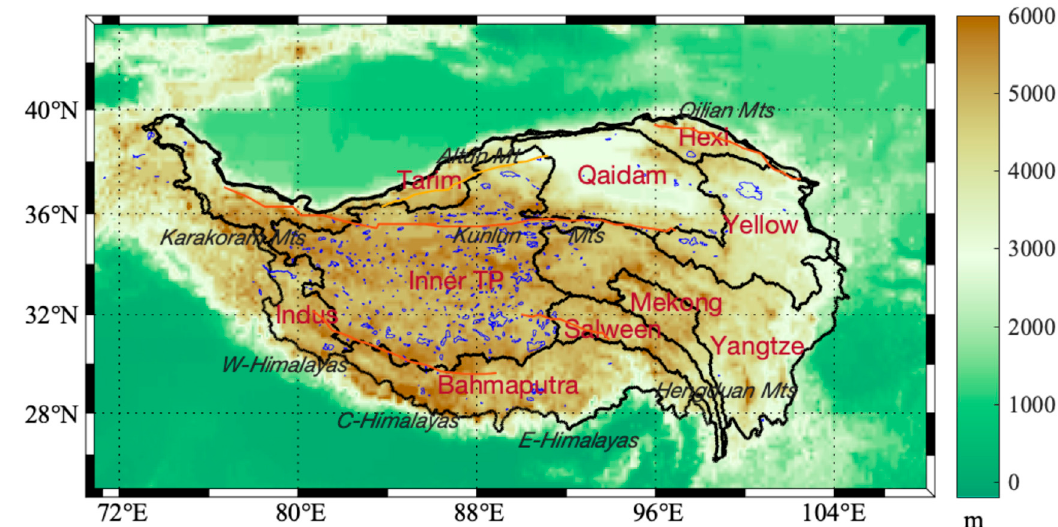
Figure 1. Topography of the Tibetan Plateau (TP) with a distribution of lakes (in blue). The whole region is divided into 10 basins, involving 7 exorheic drainage basins (Indus, Brahmaputra, Mekong, Salween, Yangtze, Yellow, and Hexi) and 3 endorheic drainage basins (Tarim, Inner TP, and Qaidam). Red lines indicate major mountain ranges.